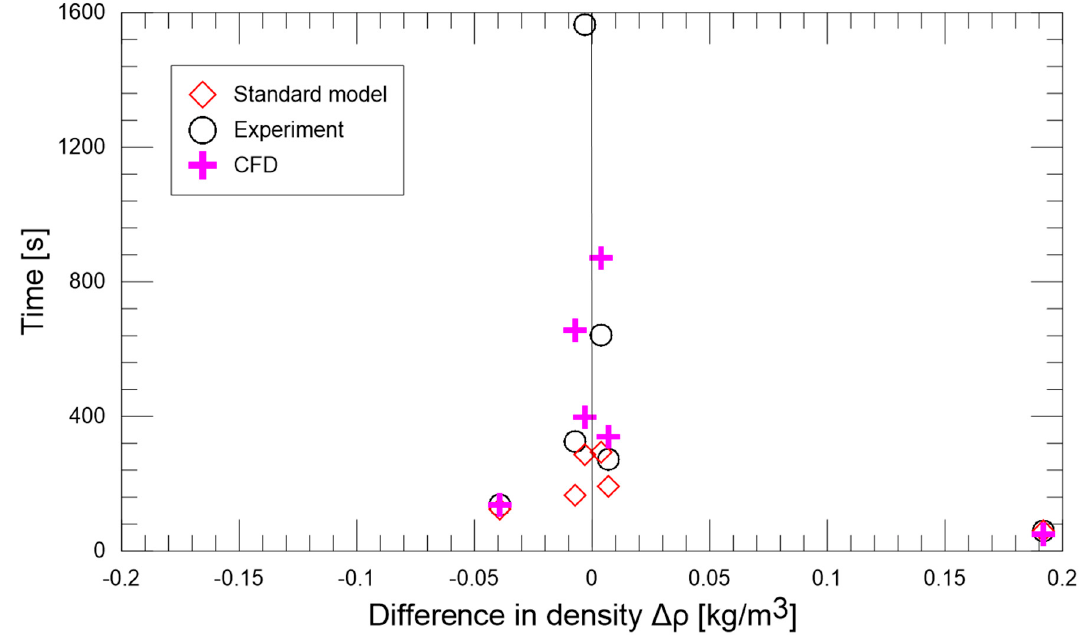
Figure 9. Comparison of the retention time estimate in experiment [11], standard model calculations and CFD analysis for different values of Δρ .